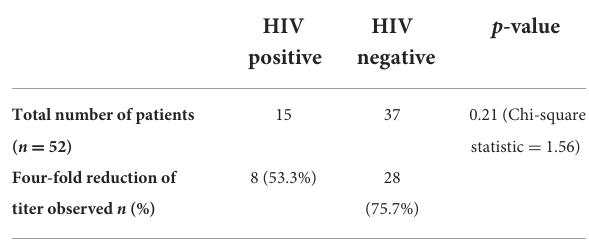
TABLE 3 Serological response to the